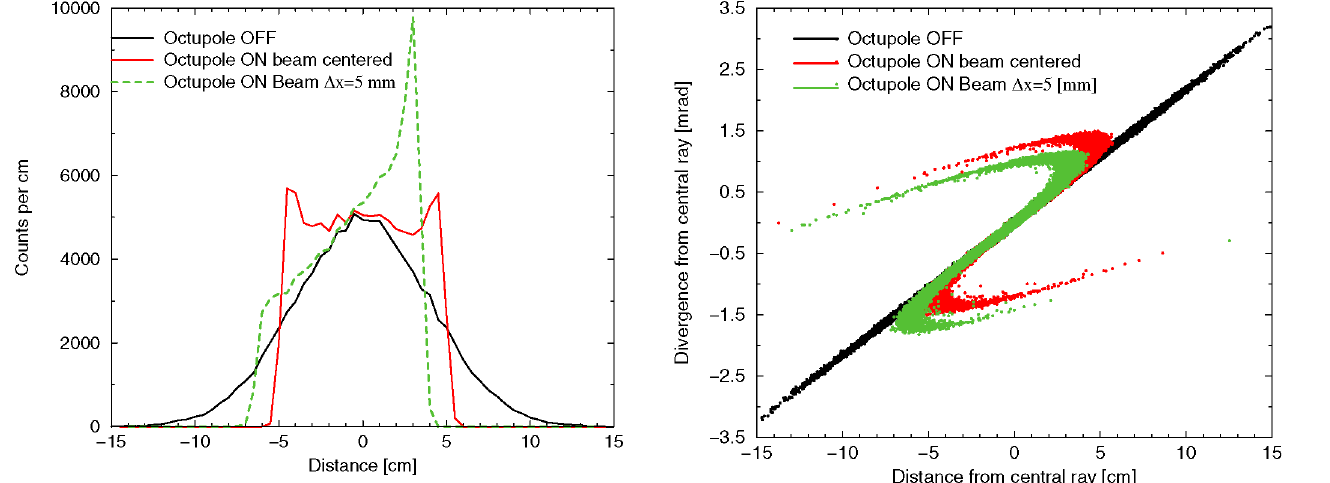
FIG. 10. (Color) Horizontal phase-space ( x; x 0 ) distributions of the beam at the target, corresponding to the settings of the horizontal octupole: (a) OFF, (b) ON, and (c) ON but misaligned with respect to the beam axis.